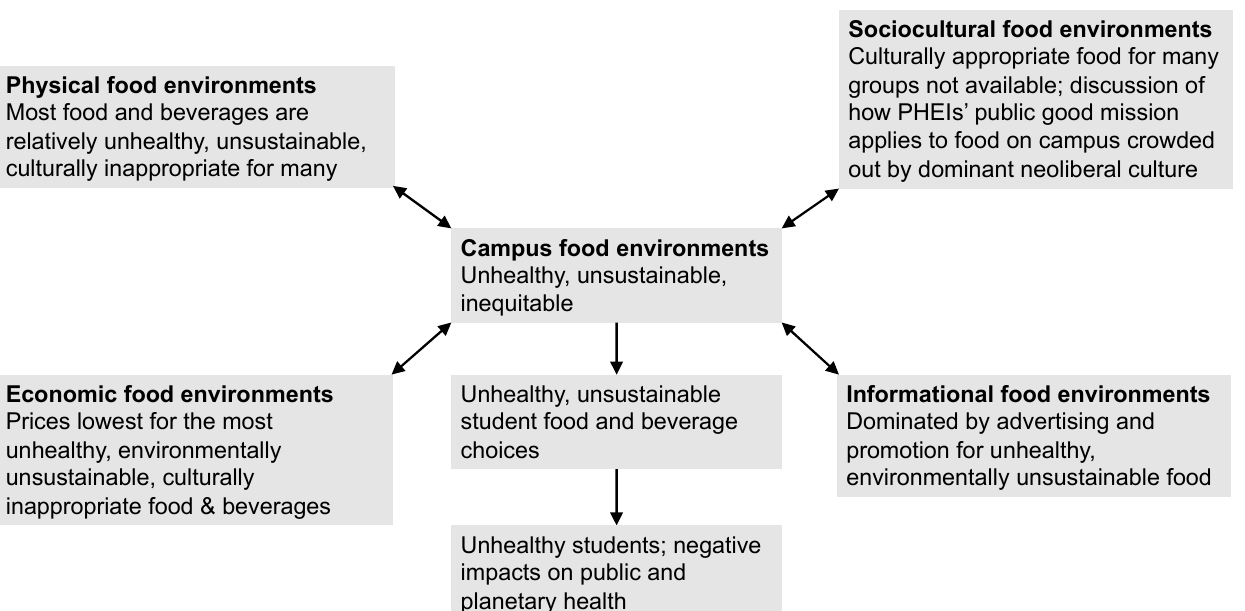
Figure 2. PHEI campus food environments, student food choice, and health. © D.A. Cleveland, used with permission.